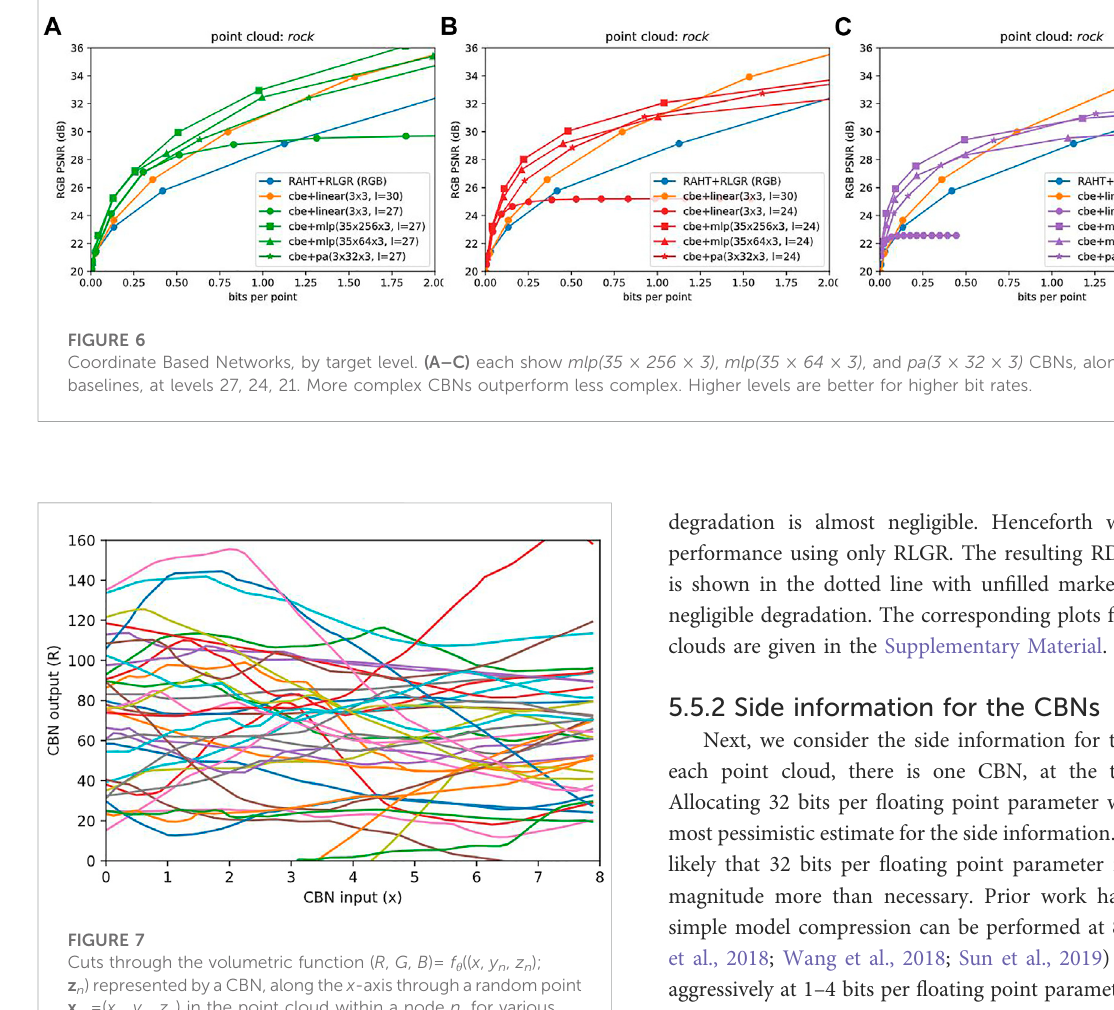
FIGURE 7 Cuts through the volumetric function ( R , G , B )= f θ (( x , y n , z n ); z n )representedbyaCBN,alongthe x -axisthrougharandompoint x n =( x n , y n , z n ) in the point cloud within a node n , for various occupied nodes n at target level 21. It can be seen that